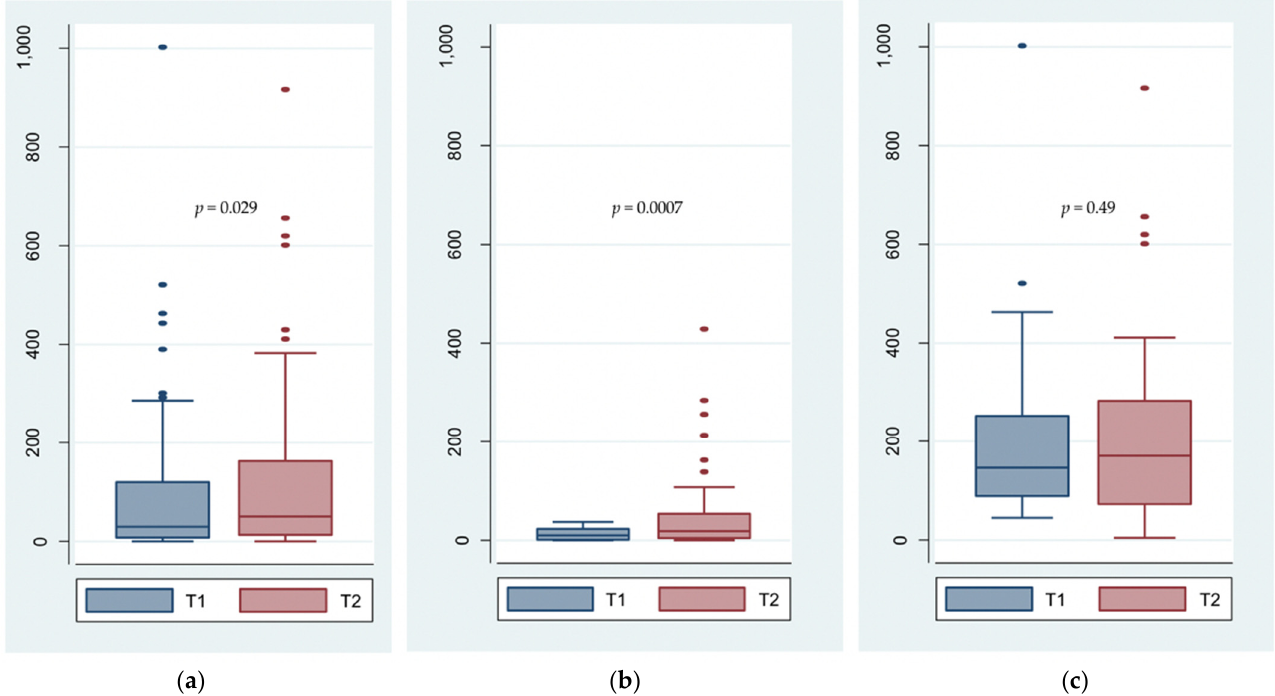
Figure 3. Box plots showing the total sperm number (TSN, 10 6 /ejaculate) before (T1) and after (T2) varicocele embolization with Glubran ® 2. ( a ) Evolution of TSN in all patients ( n = 102) between T1 and T2 showing a significant improvement ( p = 0.029); ( b ) Evolution of TSN in patients with initial abnormal TSN ( n = 60) showing a significant improvement ( p = 0.0007); ( c ) Evolution of TSN in patients with normal initial TSN ( n = 42) with no significant change between T1 and T2 ( p = Table 3. Cross-tabulation table showing the number of patients with abnormal and normal total sperm number (TSN) on the first semen analysis before varicocele embolization (VE) versus those on the second semen analysis after VE. After VE Total Sperm Number Abnormal, No. (%) Normal, No. (%) Total, No. (%) Abnormal, No. (%) Before VE